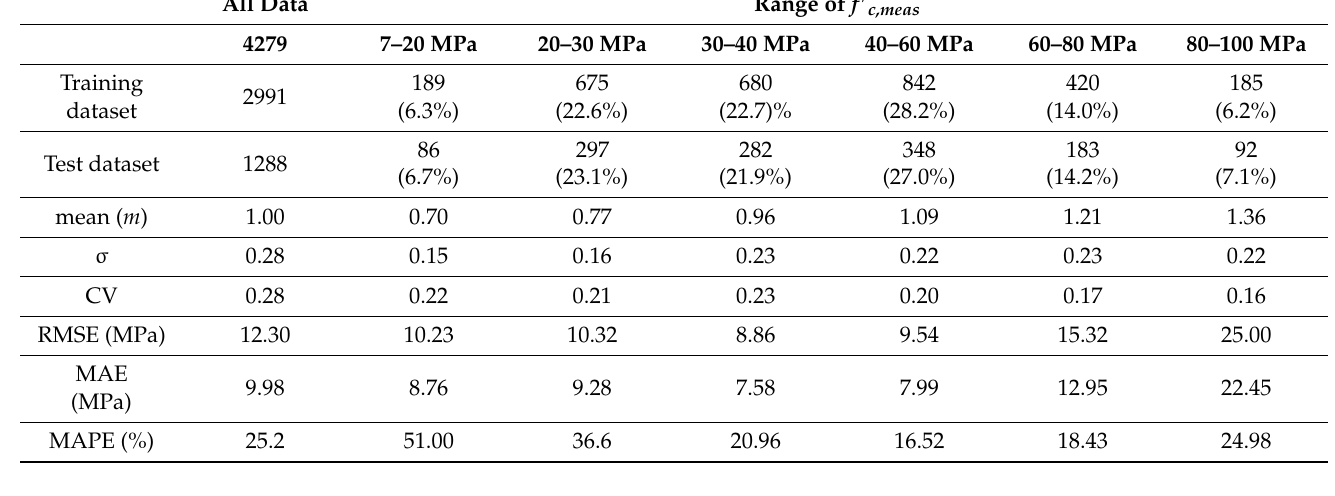
Table 2. Analysis accuracy of ML trained with f’ c,meas in all ranges.